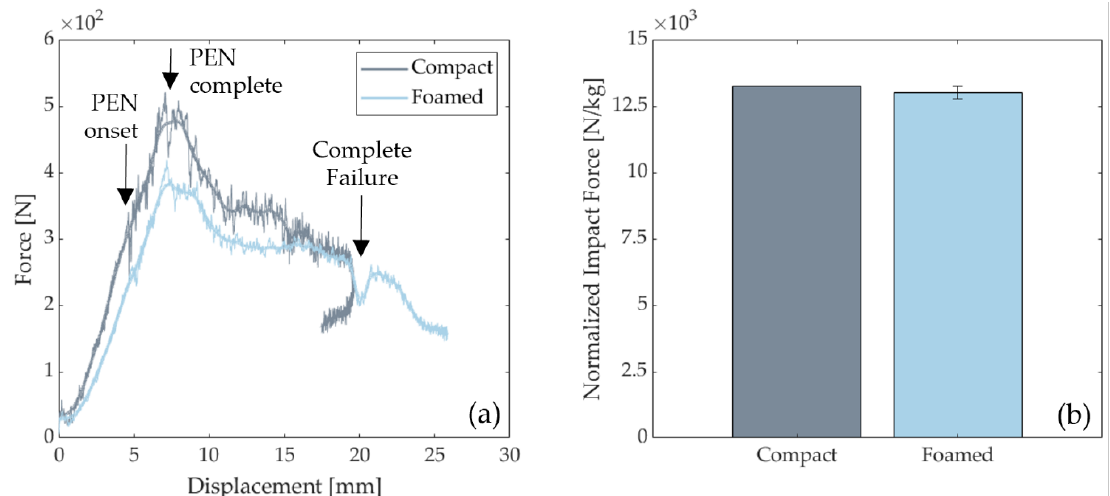
Figure 16. ( a ) Force-displacement plots of original and smoothed for compact and foamed specimens. PEN indicates penetration. ( b ) Impact force normalized with sample weight. Table 4. Representative values for foamed and compact samples from drop-tower impact testing.